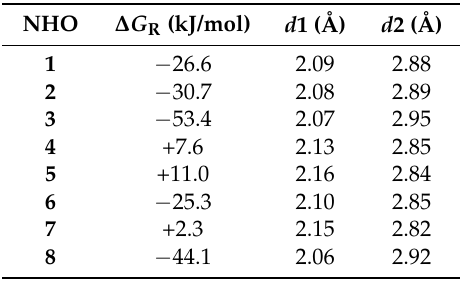
Table 2. Properties of the ZnCl 2 (NHO)(THF) complexes.